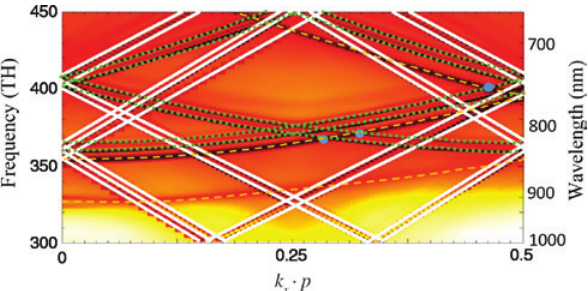
(2 k , f ), slotted 1 1 1 Figure 3: The measured normalized SESHG signal power ( P versus the pump frequency (wavelength) and the excitation angle θ (A) and equivalent normalized in-plane wavevector (B), showing four important features: (I) a peak in SHG due to the first band edge of the fundamental LP mode, (II) a peak in SHG due to the second band edge of the fundamental LP mode, (III) two peaks in SHG due to PM and (IV) a peak in SHG due to the band edge of the second-harmonic LP